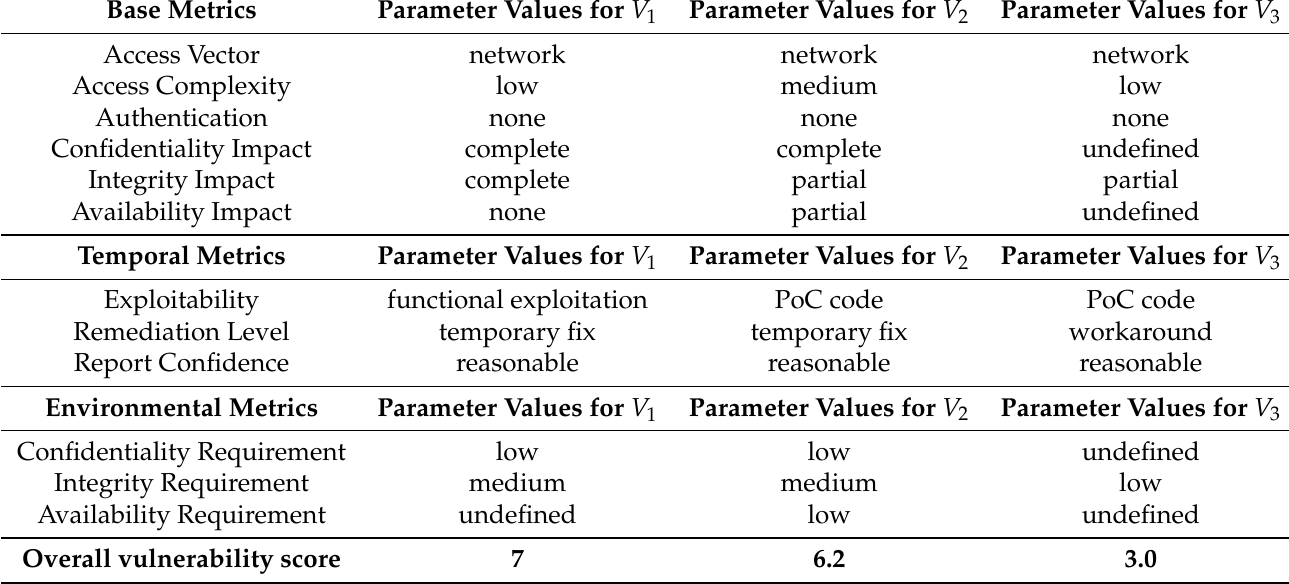
Table 5. Summary of the vulnerability analysis for the CSO-eMSP sub-systems communication. The parameter values indicate our choice to the different metrics of the CVSS methodology. Three different types of vulnerabilities V 1 , V 2 , and V 3 are identified for this